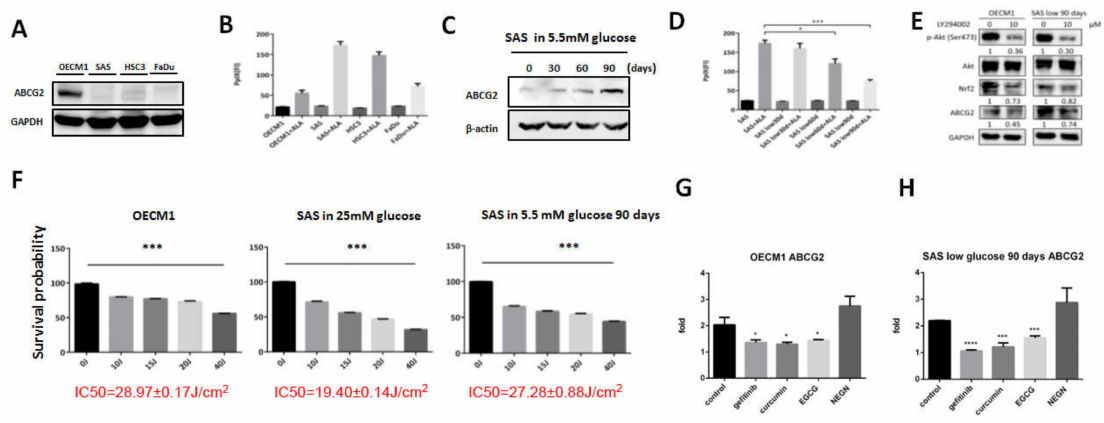
Figure 1. ATP-binding cassette G2 (ABCG2) expression was di ff erent in varied head and neck cancer (HNC) cell lines, which a ff ected the amount of protoporphyrin IX (PpIX) and the survival percentage while the cells were treated with 5-aminolevulinic acid photodynamic therapy (ALA-PDT), and